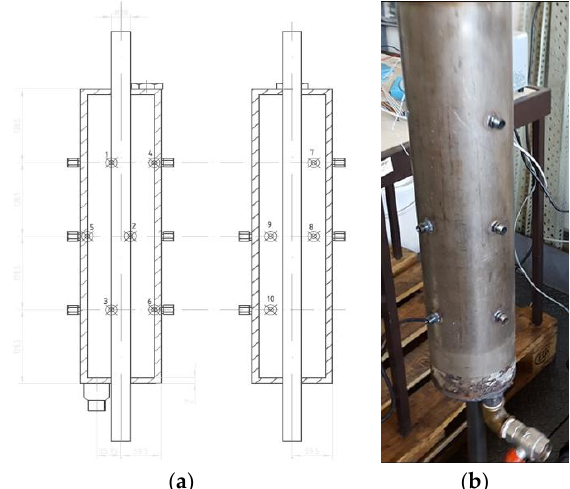
Figure 3. PCM heat exchanger. ( a ) Heat exchanger drawing; ( b ) Picture of the PCM heat exchanger.